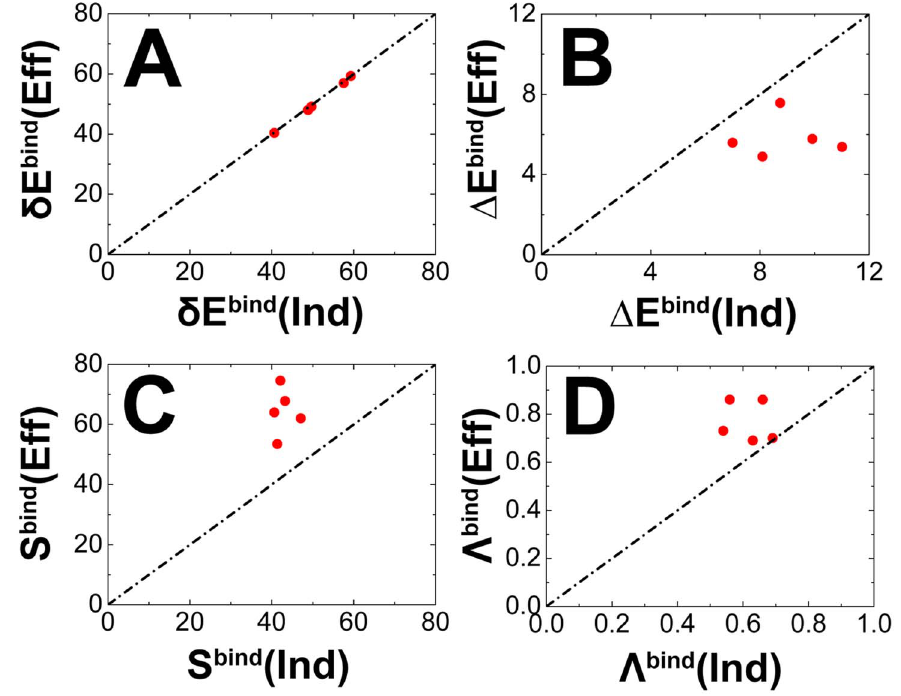
Figure 3. The relationship of the topography of energy landscapes between rigid and flexible binding. The quantities of topography of energy landscapes are shown in (A) energy gap d E bind , (B) energy roughness D E bind , (C) entropy S bind and (D) energy landscape topography measure L bind .